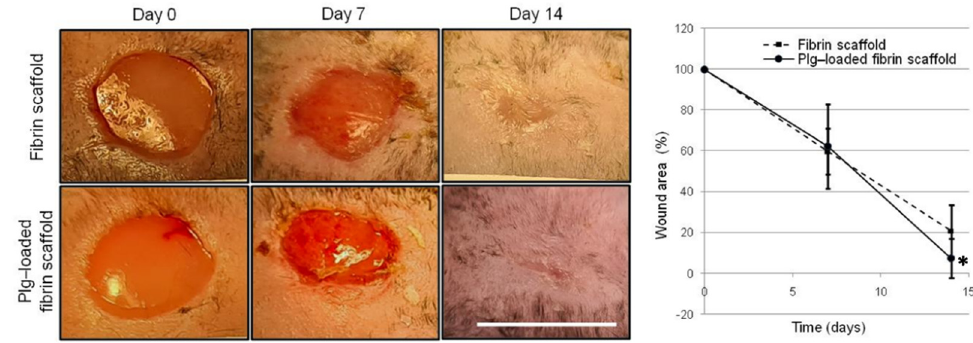
Figure 6. On the left, representative images of lesions treated with fibrin scaffold and Plg-loaded fibrin scaffold at 0, 7 and 14 days (scale bar = 1 cm). On the right, percentage of wound area at 7 and 14 days.